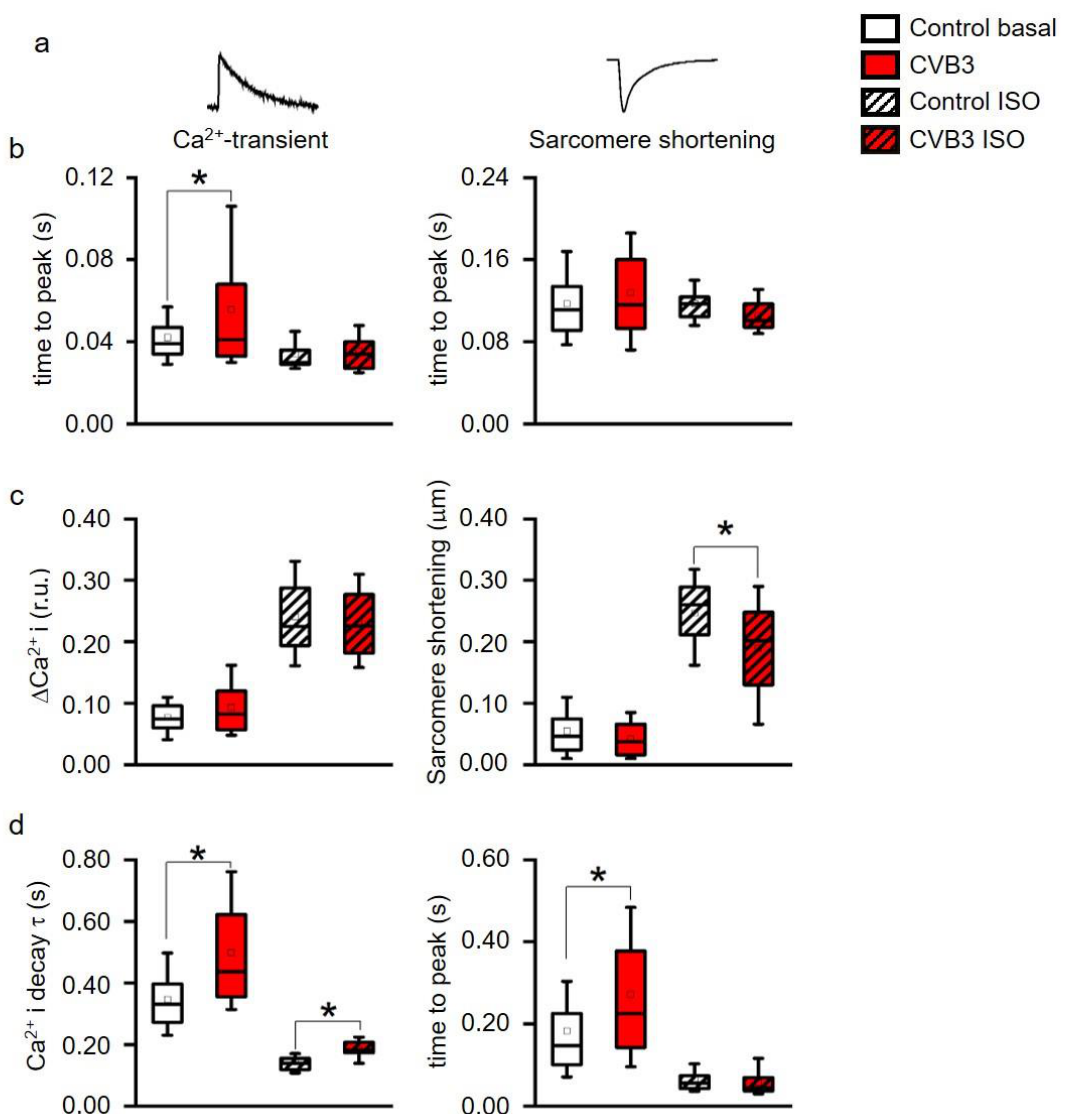
Figure 4. ( a ) Time to peak of intracellular Ca 2+ (Ca 2+ I ) transients and of sarcomere shortening, ( b ) Ca 2+ -transient ( ∆ Ca 2+ i ) and sarcomere shortening amplitudes, ( c ) time constant τ of a single exponential decay function fitted to the decay phase of Ca 2+ -transients and to sarcomere relaxation phase. * indicates p < 0.05 vs. WT controls. All parameters recorded under acute stimulation with isoproterenol (ISO) were significantly altered vs. basal ( p < 0.05, not indicated in the figure for clarity). (box: 25th – 75th percentile, whiskers: 10th – 90th percentile, horizontal line: median, square: mean). (d) decay of Ca 2+ and time to peak were simultaneously measured and analyzed. Ca 2+ decay time was significantly altered between control and CVB3-expressing cardiomyocytes under basal and stimulated conditions. Time to peak was only altered under basal conditions indicating a calcium-contraction uncoupling due to CVB3 expression (* indicates p < 0.05).